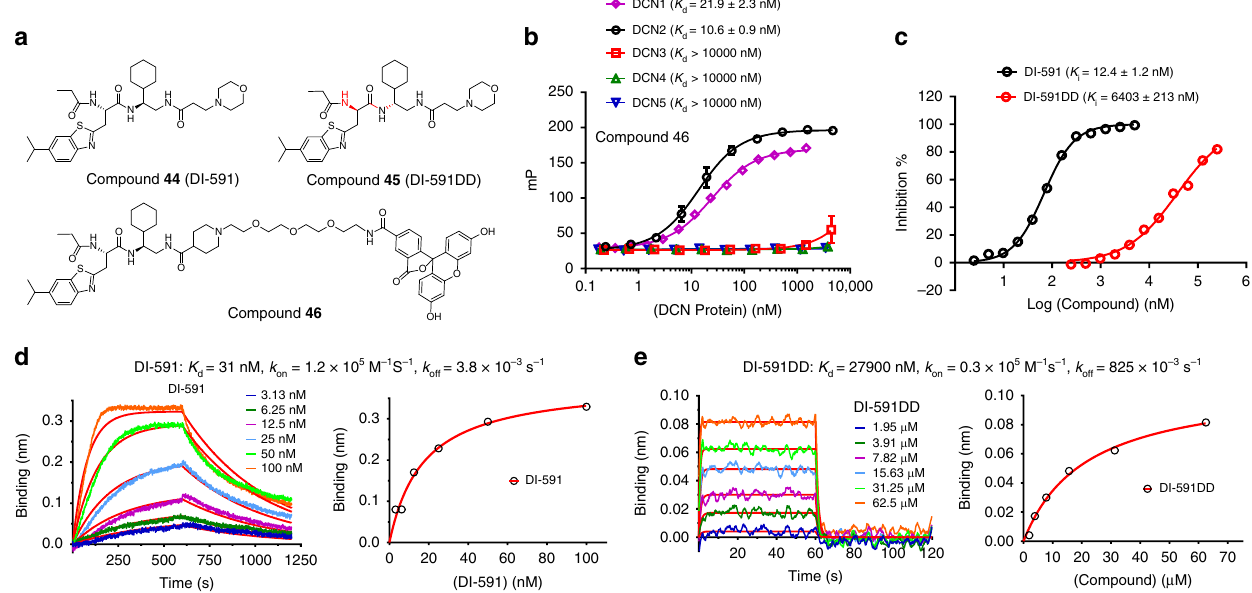
Fig. 2 Characterization of DI-591 binding to DCN proteins. a Chemical structures of DI-591, DI-591DD and the fl uorescent labeled compound 46 . b Saturation curves of 46 with indicated DCN proteins. c Competitive binding curves of DI-591 and DI-591DD to DCN1 using a competitive fl uorescence polarization assay. d Kinetic binding sensorgrams of DI-591 and the steady state fi tting of the equilibrium responses vs compound concentrations based on 1 : 1 binding model. e Kinetic binding sensorgrams of DI-591DD and the steady state fi tting of the equilibrium responses vs compound concentrations based on 1:1 binding